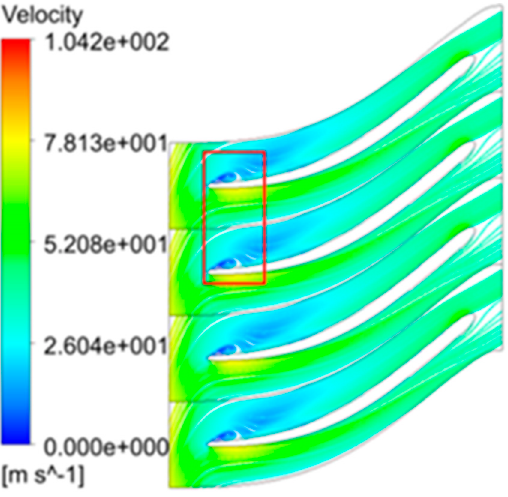
Figure 15. Streamline distribution of traditional impeller.